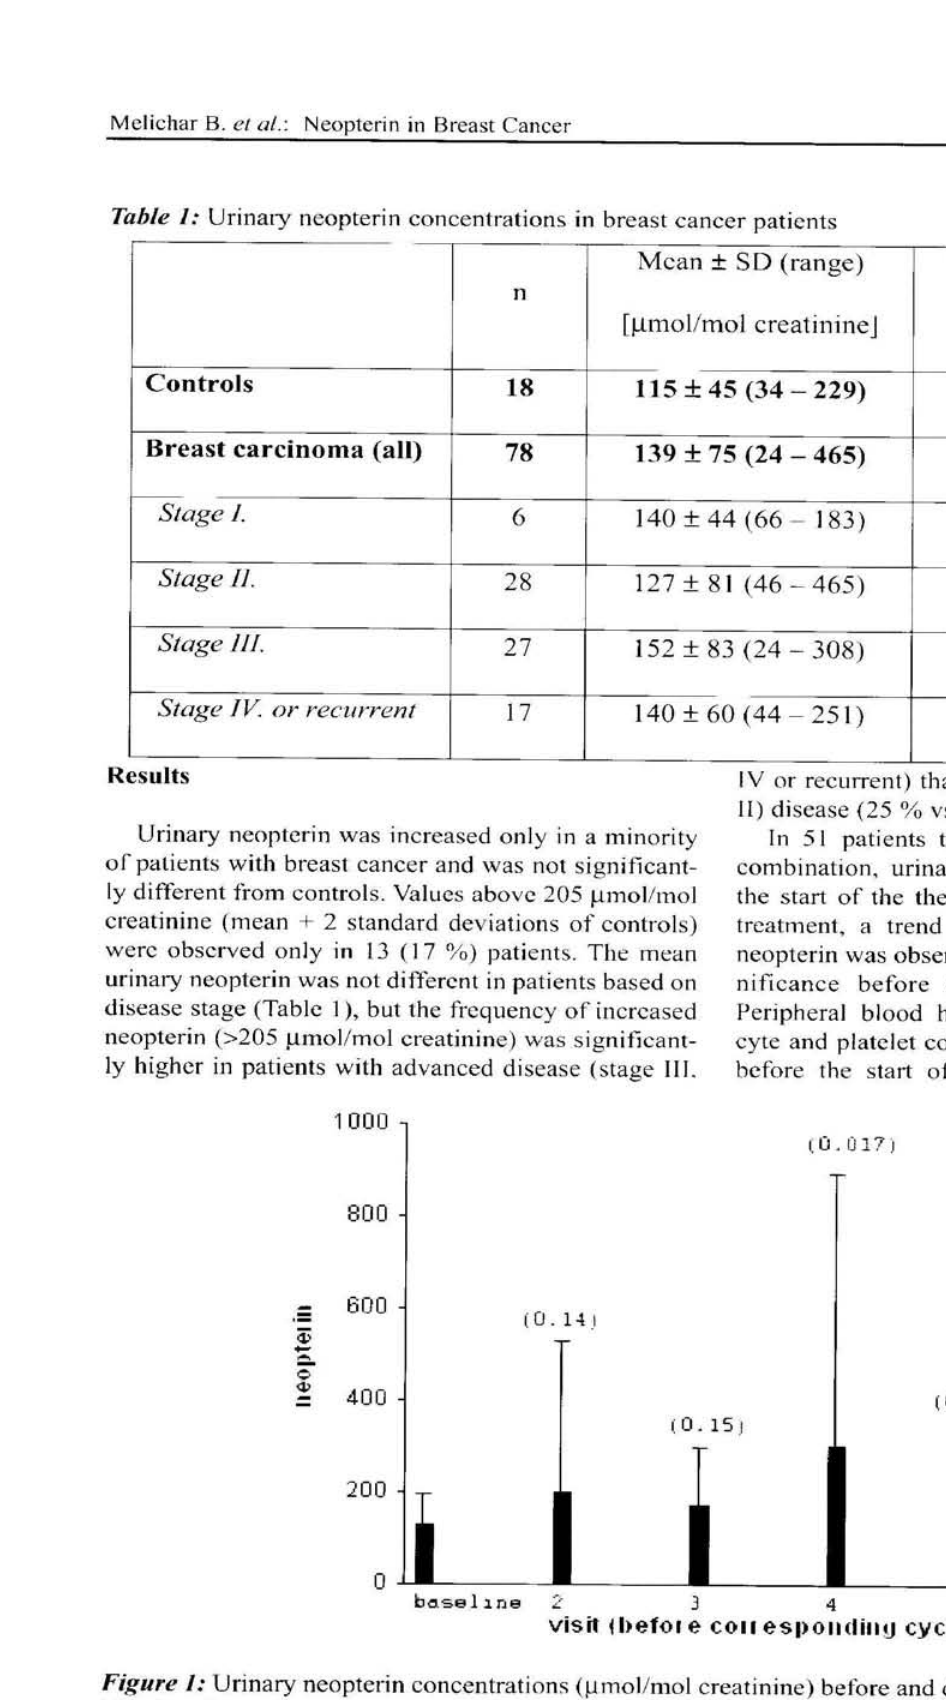
Mean ± SD (range) η [μιηοΐ/mol Creatinine]